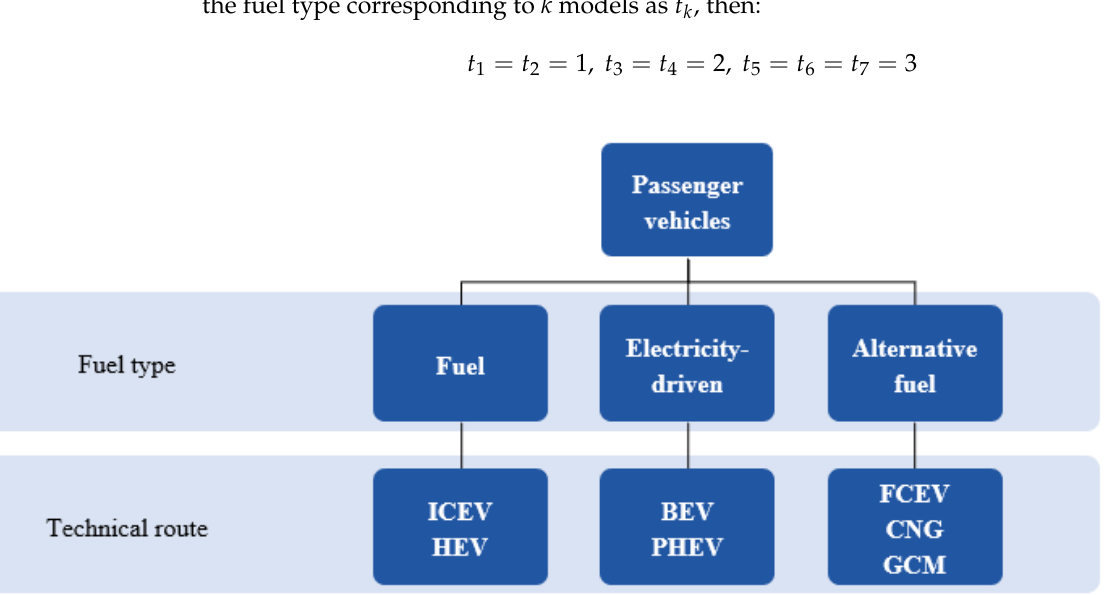
Figure 4. Structure of the NMNL model .